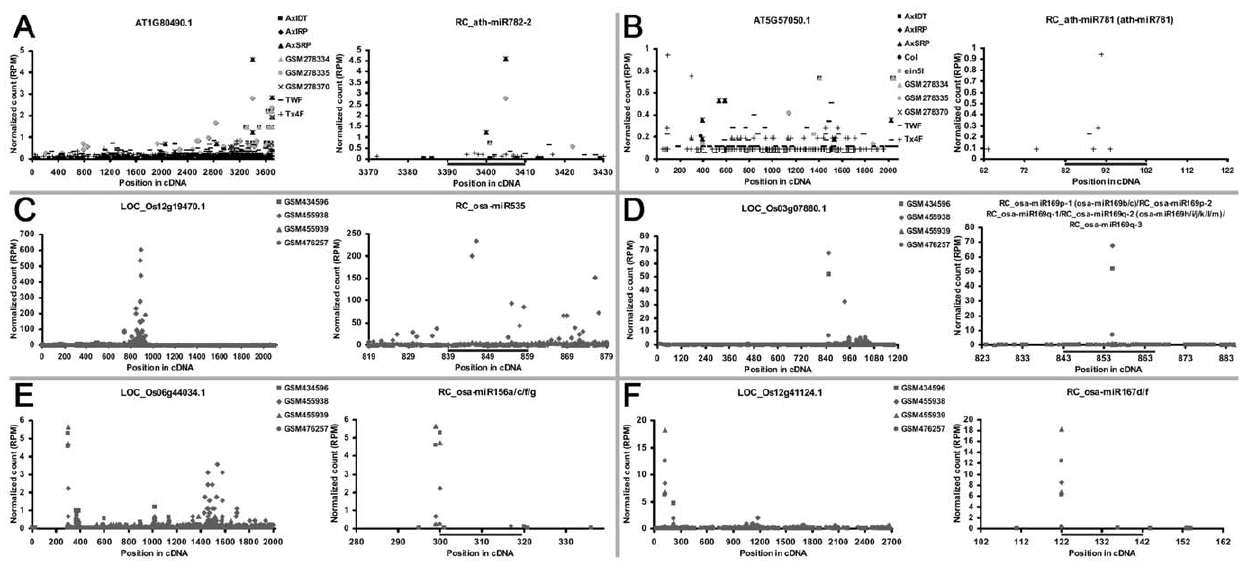
Figure 3. Degradome sequencing data-based identification of the targets of the highly accumulated reverse complementary microRNAs (RC-miRNAs) in Arabidopsis and rice. For all the sub-figures (A to F), the left panels depict the degradome signals all along the target transcripts, and the other panels provide detailed views of the cleavage signals within the regions surrounding the target recognition sites (denoted by gray horizontal lines). The transcript IDs are shown in the left panels, and the RC-miRNA names are listed in the other panels. The x axes measure the positions of the signals along the transcripts, and the y axes measure the signal intensities based on normalized counts (in RPM, reads per million), allowing cross-library comparison. See Table S2 for the degradome data sets used in this analysis.